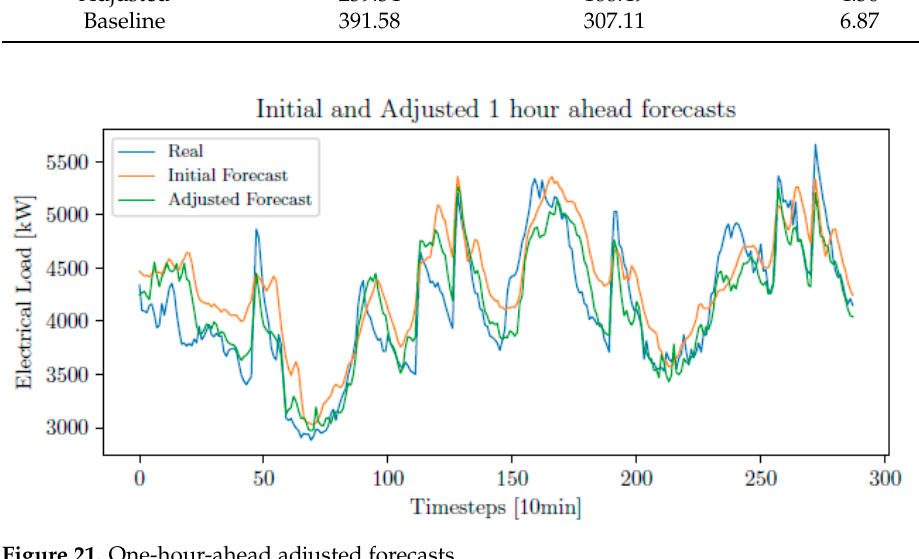
Figure 21. One-hour-ahead adjusted forecasts.